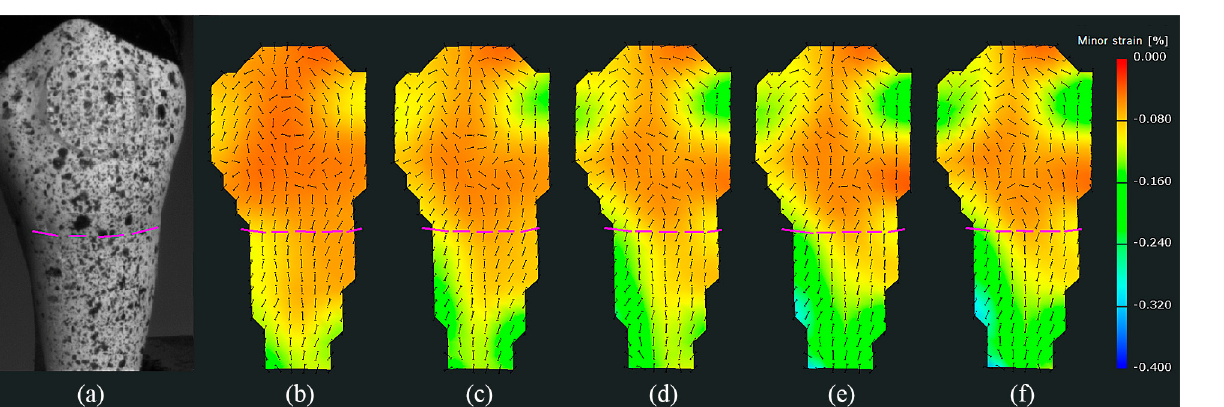
Figure 6. The orientation fields of the minor strains in Figure 4. ( a ) Specimen. ( b – f ) Stage 5, stage 10, stage 20, stage 30, and stage 39, respectively. The short thin black lines (unit vector), mapped onto the value fields, represent the directions of minor strains, while the purple dotted lines represent the location of the CEJ.